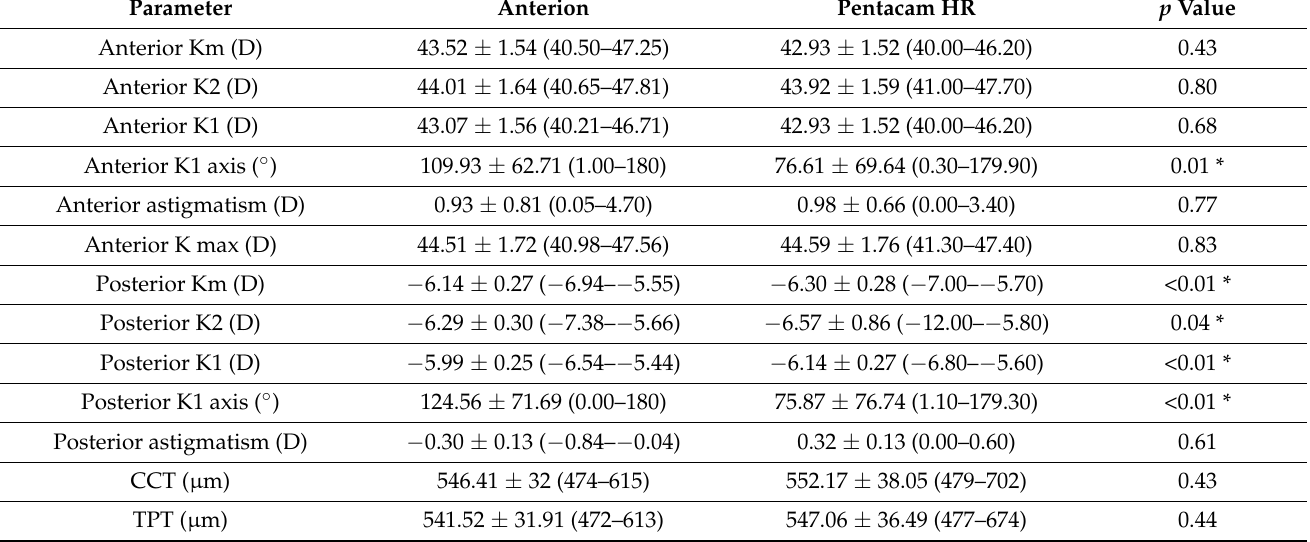
Table 1. Descriptive analysis. Comparison of corneal parameters between the Anterion and Pentacam HR devices.